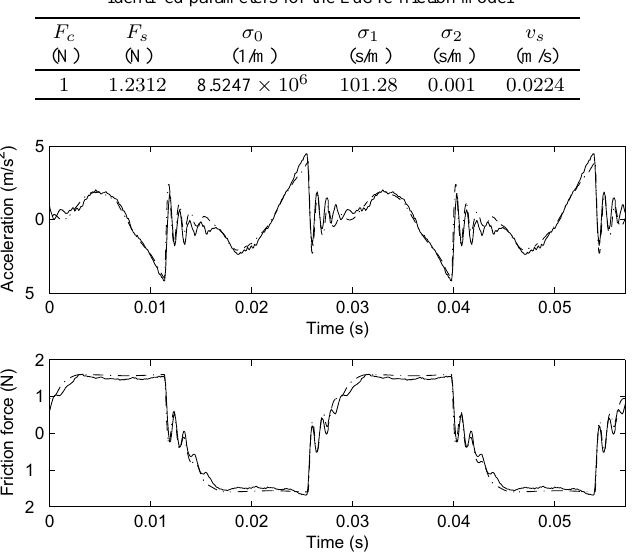
Table 4 Identified parameters for the LuGre friction model